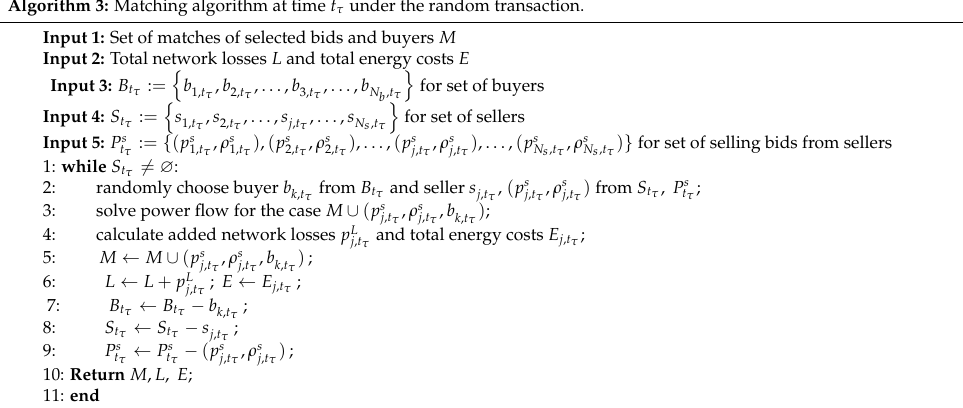
Algorithm 3: Matching algorithm at time t τ under the random